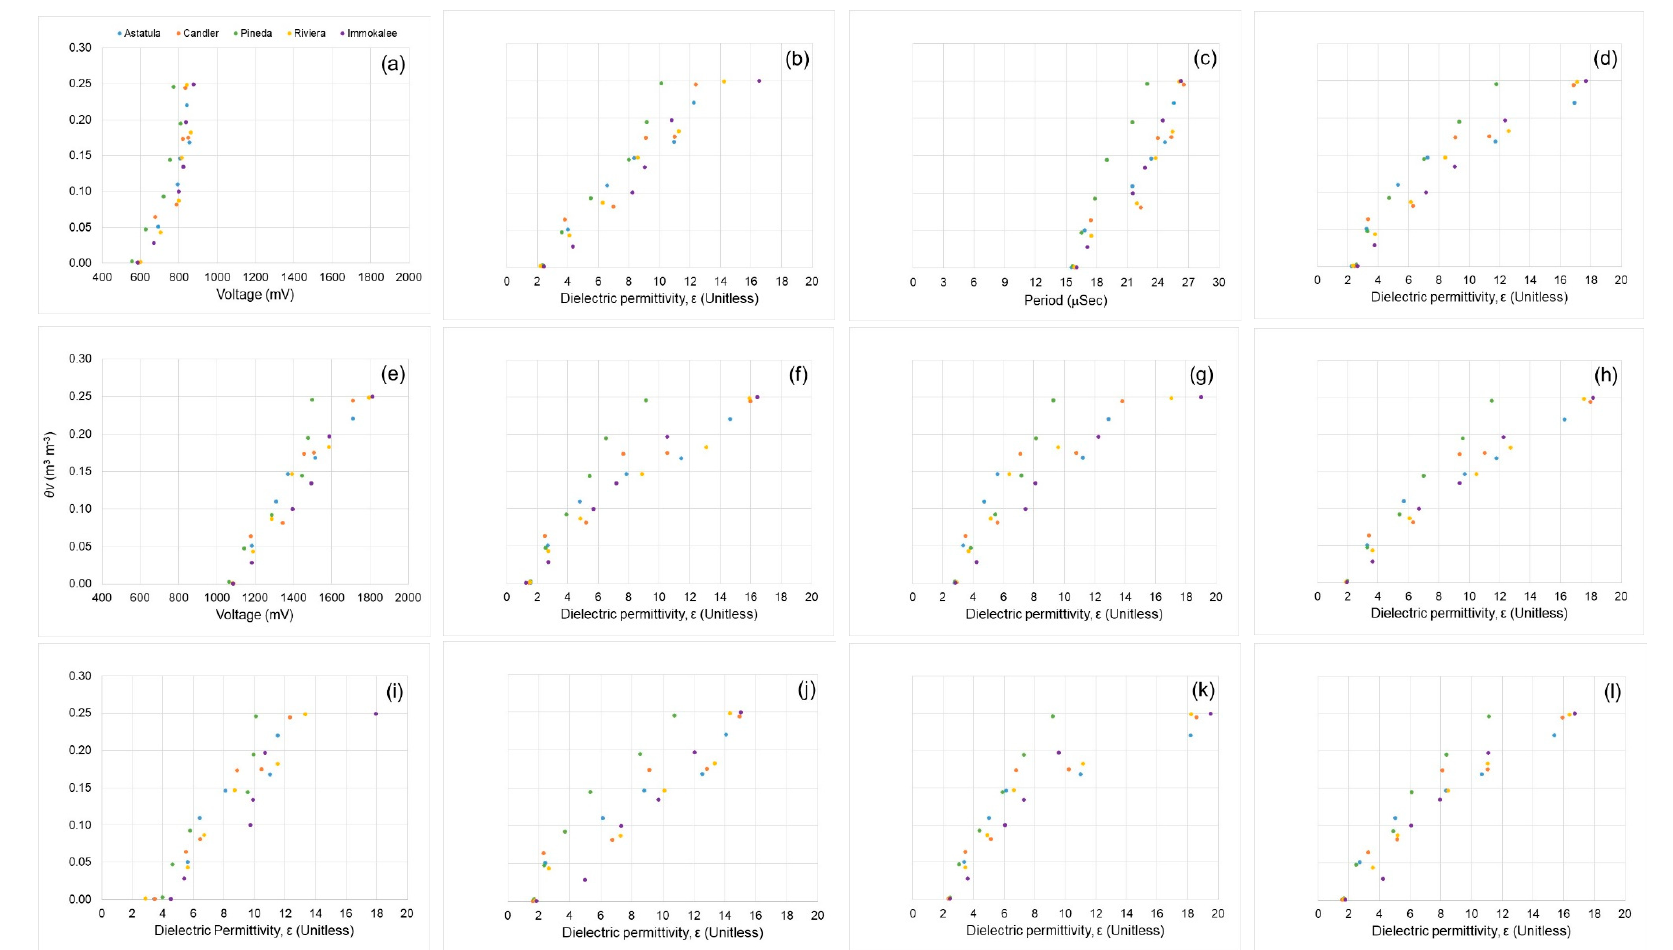
Figure 6. Raw values measured by all commercial soil moisture sensors in the soil top layer (0.0–0.3 m): 10HS ( a ), 5TE ( b ), CS616 ( c ), TDR315 ( d ), GS1 ( e ), CS655 ( f ), Hydra Probe ( g ), TDR315L ( h ), GS3 ( i ), CS650 ( j ), TDT-ACC-SEN-SDI ( k ), and TDR310S ( l ). Each data point is the average of the three samples of the soils taken from each of the three replications by soil series ( n = 9).